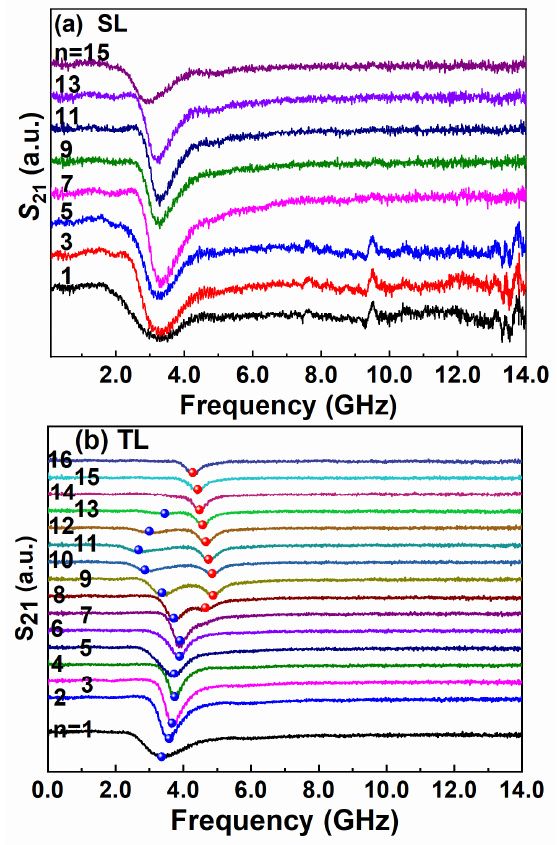
Figure 3. The S 21 – f curves along EA at zero external field at various test positions n for ( a ) single layer and ( b ) trilayer. The angle-dependent polar diagrams of FMR frequency and S 21 amplitude at zero